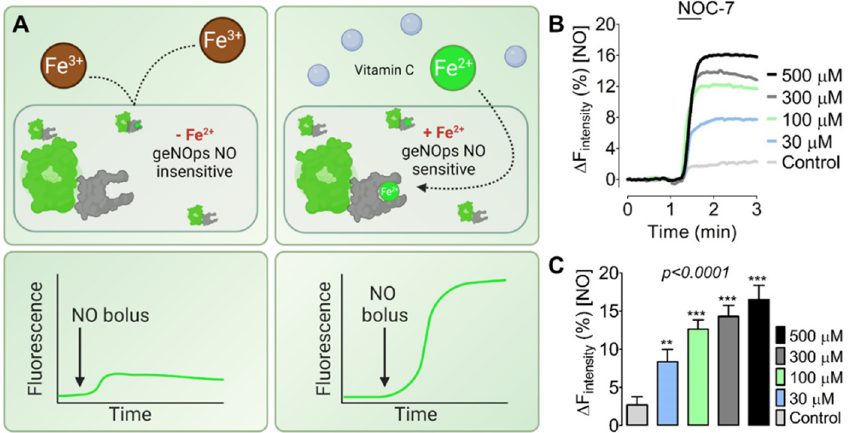
Figure 1. NO biosensor reports labile iron (II) in a concentration-dependent manner. ( A ) The cartoon shows iron (II) dependency of the NO biosensor geNOps. If iron salts are provided to cells, only ferrous iron can enter the cell cytosol through DMT1 channels but not ferric iron. Non-heme iron consisting of geNOps can sense NO in an iron (II)-concentration-dependent manner. ( B ) Average curves show real-time NO signals in response to 10 µM NOC-7 in HEK293T cells expressing O- geNOps. Cells have been treated with equimolar concentrations of FeSO 4 and Vitamin C, respec- tively, for 20 min before imaging experiments: 500 µM (black curve, n = 3/60), 300 µM (dark grey curve, n = 3/54), 100 µM (green curve, n = 3/56), 30 µM (blue curve, n = 3/42), and control no treatment (light grey curve, n = 3/73). ( C ) Bars represent the statistical analysis of iron (II) dependent geNOps responses shown in panel b. All values are given as ±SD, and Dunnet’s multiple comparison test was applied. ** 0 vs. 30 um, Mean Difference (Diff): − 5.525, q = 5.182, 95% Confidential Interval (CI) of Diff: − 8.607 to − 2.443; *** 0 vs. 100 um; Mean Diff: − 9.870; q = 9.257, 95% CI of Diff: − 12.95 to − 6.79; *** 0 vs. 300 um; Mean Diff: − 11.400; q = 10.69, 95% CI of Diff: − 14.48 to − 8.32; *** 0 vs. 500 um; Mean Diff: − 13.800; q = 12.94, 95% CI of Diff: − 16.88 to − 10.71. Figure 2. Evaluation of the ferric iron chelator HBED and its effectiveness in different cultured cells to activate geNOps. ( A ) Representative wide-field images show immortalized endothelial cells (Ea.hy926), ( B ) human embryonic kidney cells (HEK293T), and ( C ) cervical cancer cells (HeLa) ex- pressing cytosolic O-geNOps. Lower Panels: Average curves show NO responses of cells in response to 10 µM NOC-7 that have been treated with equimolar concentrations of HBED and Vitamin C, 1 mM, respectively, for 20 min before imaging experiments. The left panel shows Ea.hy926 cells (con- trol grey curve, n = 3/60; HBED-treated, red curve, n = 3/74), middle panel HEK293T cells (control grey curve, n = 3/54; HBED-treated, red curve, n = 3/66) and the right panel shows HeLa cells (control grey curve, n = 3/29; HBED-treated, red curve, n = 3/18). All values are given as mean ± SD, and Student’s t -test was applied to compare maximum amplitudes between HBED-treated cells and con- trol cells. (A) *** p = 0.0003, (B) ** p=0.0081, (C) ** p = 0.0014.